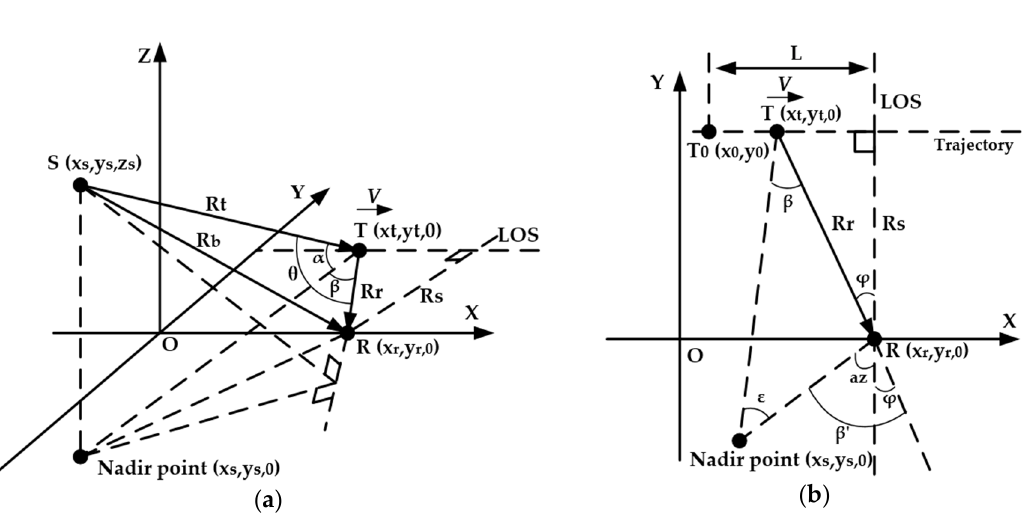
Figure 3. Different views of the bistatic acquisition geometry: ( a ) is the three-dimensional view, and ( b ) is the top view.